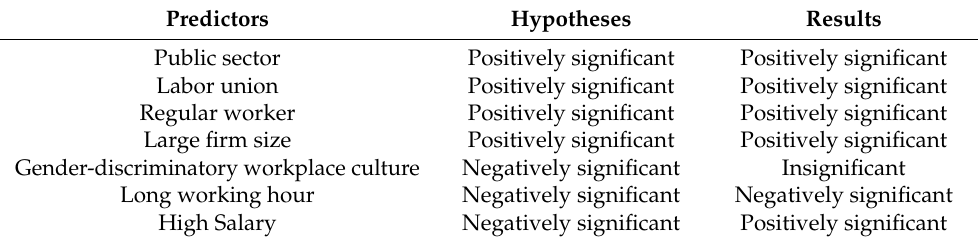
Table 5. Summary of the